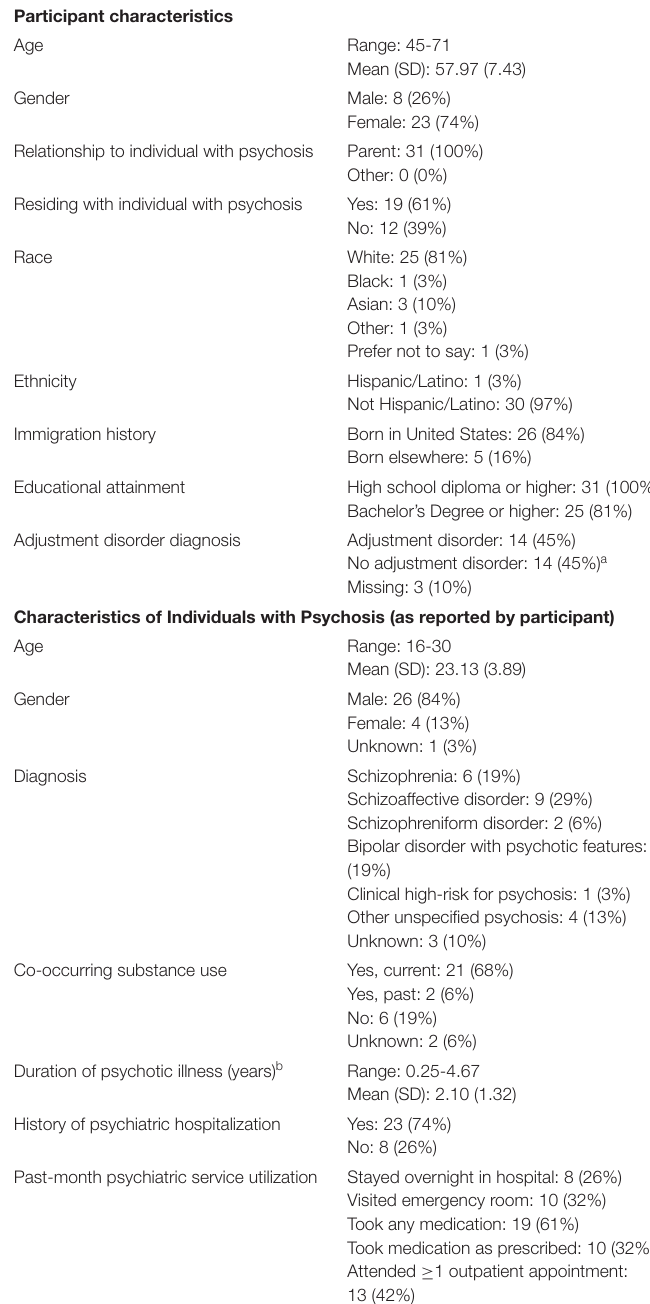
TABLE 2 | Participant Characteristics ( N = 31). Participant